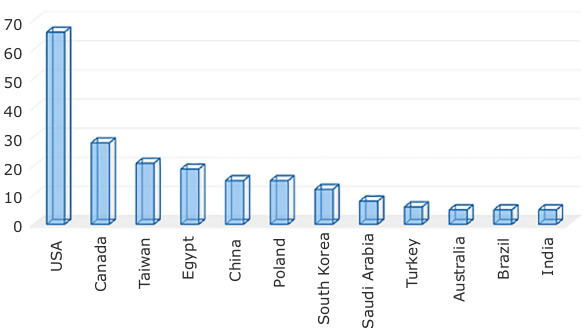
Figure 4. Distribution of publications by